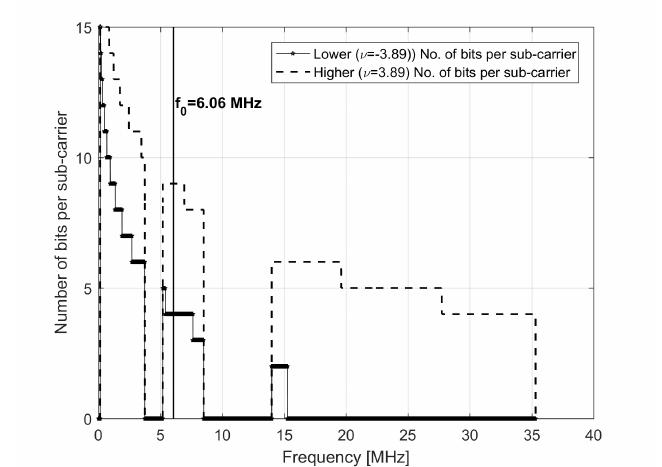
Figure 8. Number of bits per sub-carrier as a function of the frequency; VDSL2 profile 35b has been